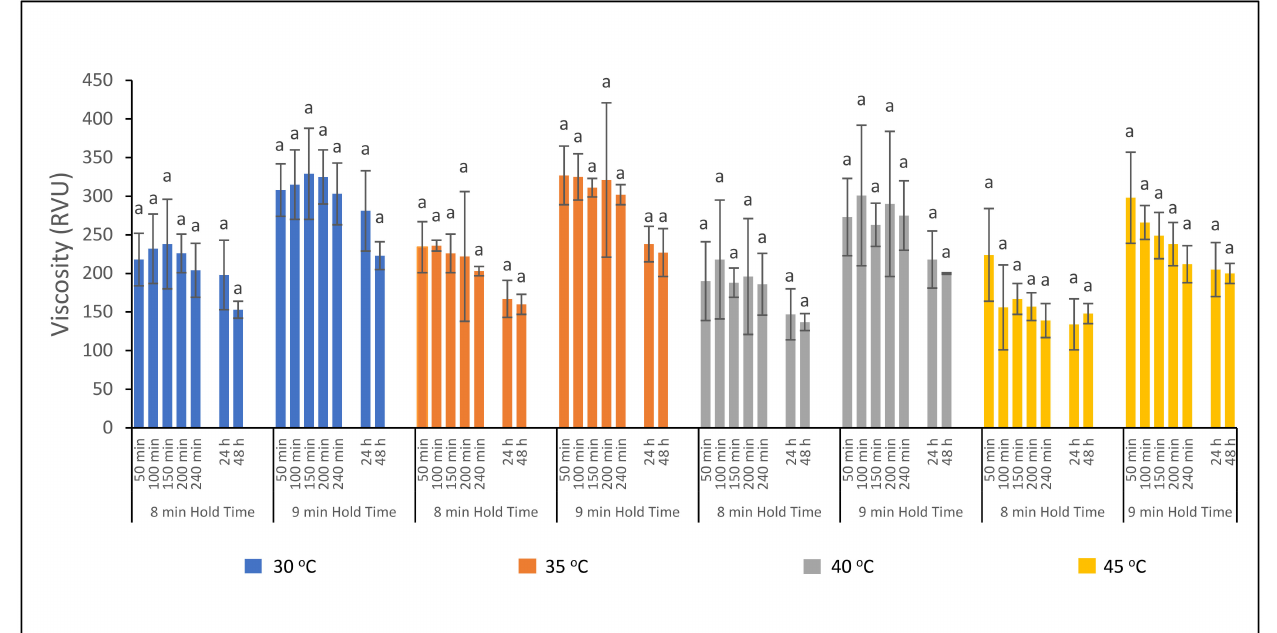
Figure 11. Impact of fermentation temperature on ferment viscosity measured at 8 and 9 min holding time of the pasting profile during fermentation and ferment storage at 24 h and 48 h. Bars represent the means and standard deviations of two replications. No significant differences were detected for the results for each fermentation temperature and hold time at p < 0.05 (Tukey–Kramer test) as indicated with the bars with the same